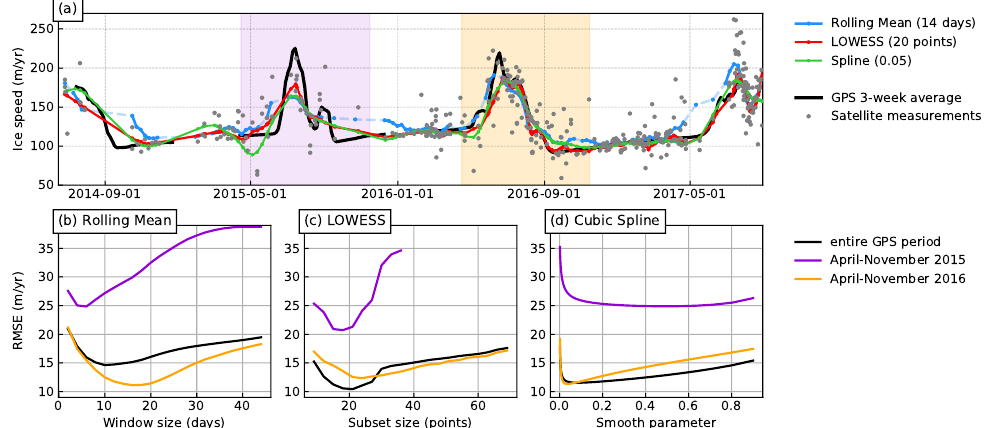
Figure 8. ( a ) Ice speed versus time from GPS (black line) and satellites (gray points) with reduction results (colored lines) from rolling mean, cubic spline, and LOWESS at the GPS location as indicated by the red dot at Figure 1. GPS-based ice speed is averaged over 3 weeks. ( b – d ) Root-mean-square error (RMSE) between ice velocity from averaged GPS and the different reduction approaches as functions of their adjustment parameters. For the rolling mean ( b ), LOWESS ( c ), and cubic spline regression ( d ), this adjustment parameter corresponds to the window size, the number of points in the subset, and the smoothing parameter, respectively. The black, violet, and orange curves show the RMSE for entire GPS period between 15 July 2014 and 14 July 2017, the part of 2015 for which few satellite measurements are available, and part of 2016 for which many satellite measurements are available,